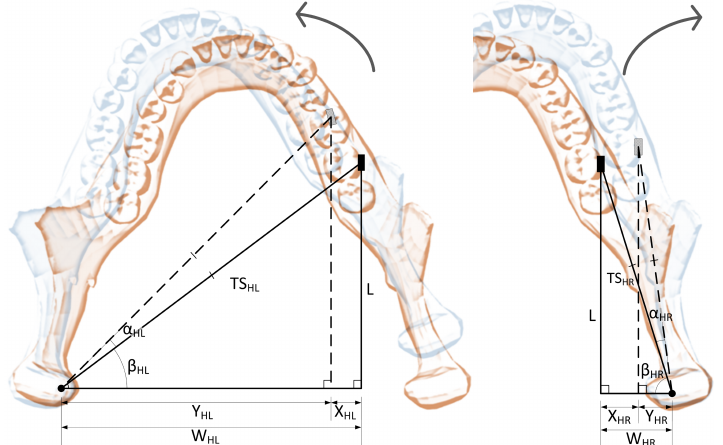
Figure 3. Horizontal rotation angle relation to left and right horizontal linear displacements. Based on [20].